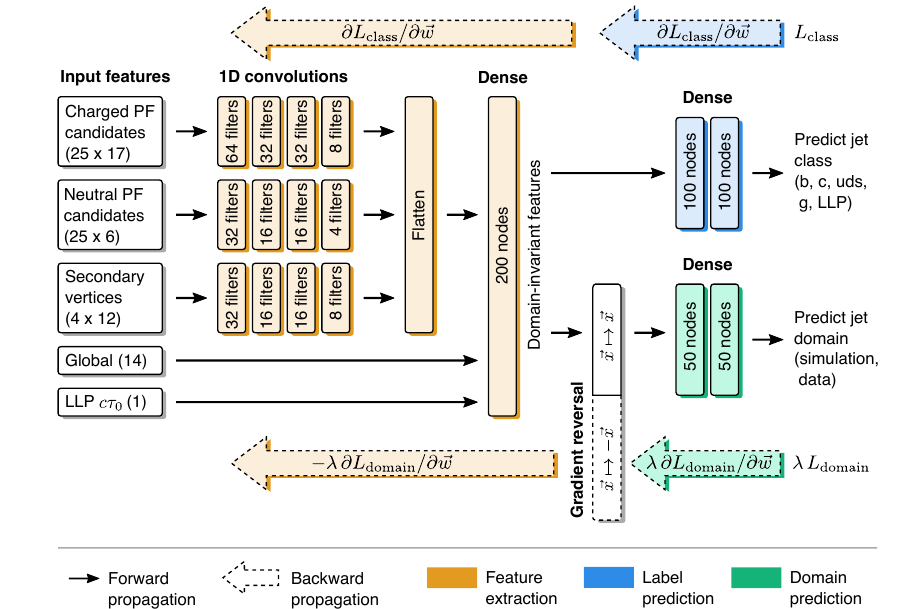
Figure 2. An overview of the DNN architecture, which comprises convolutional and dense layers; the numbers of filters and nodes are indicated. The input features are grouped by object type and ( m × n ) indicates the maximum number of objects ( m ) and the number of features per object ( n ). The gradients of the class ( L class ) and domain ( L domain ) losses with respect to the weights w , used during backward propagation, are shown. The figure is taken from Ref.